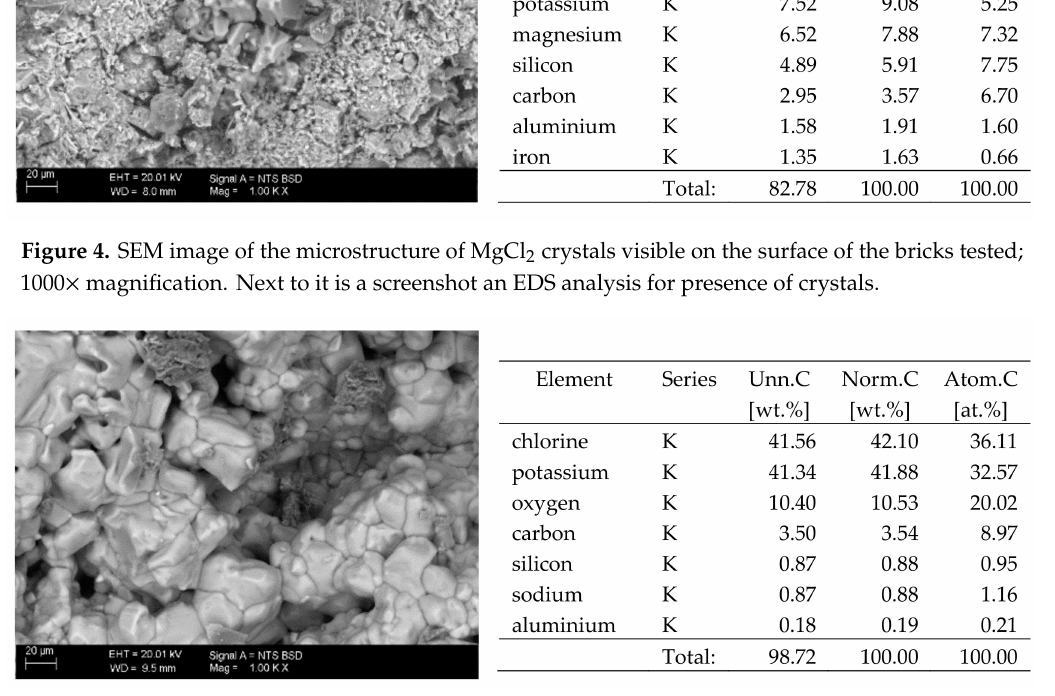
Figure 5. SEM image of the microstructure of KCl crystals visible on the surface of the bricks tested; 1000 × magnification. Next to it is a screenshot an EDS analysis for presence of crystals.